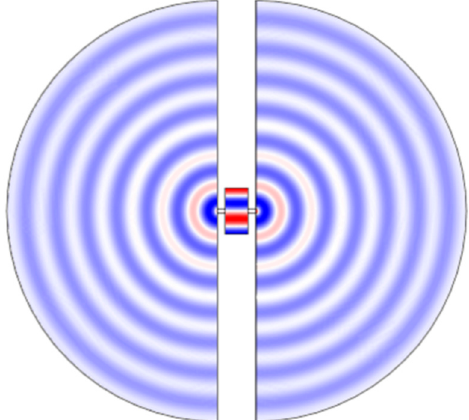
Figure 13. 2-D model of a third harmonic lateral-extensional resonator. The strain is color-coded on the resonator and the substrate but the color intensity is not a true representation of the strain intensity as it is manipulated on the substrate region to enhance visibility.